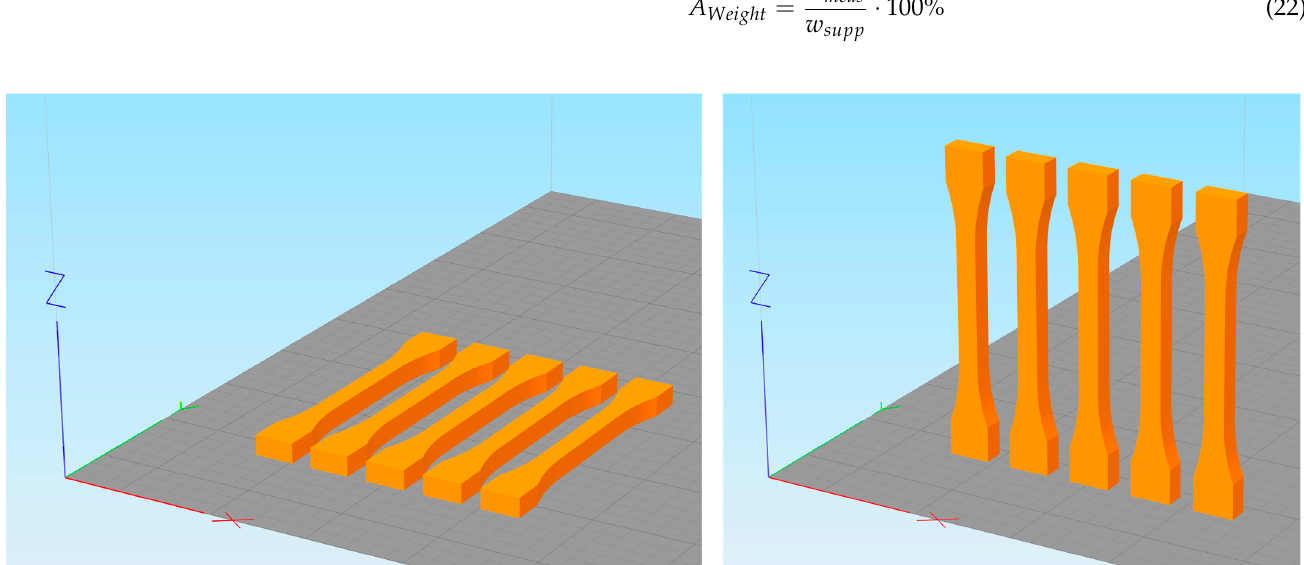
Figure 4. Five tensile test specimens according to DIN EN ISO 527 in lying ( left ) and standing orientation ( right ).